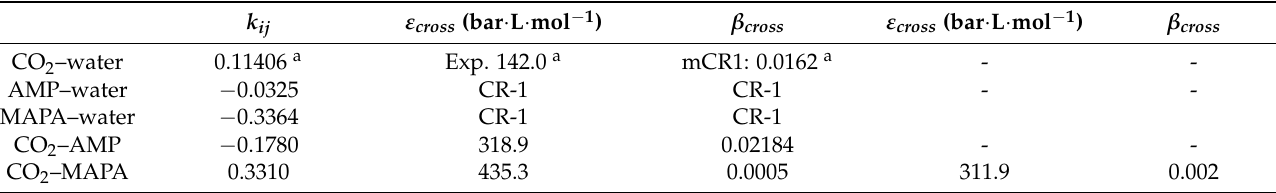
Table 9. CPA binary parameters used in this